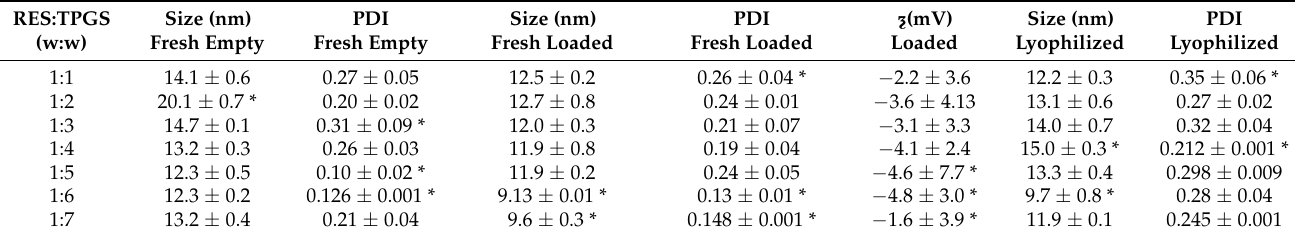
Table 2. Mean diameter (size, nm) and PDI of freshly prepared empty and loaded micelles and of formulations reconstituted from lyophilized powder, RES-TPGS formulations. The zeta potential ( B ) values were detected on fresh RES-TPGS micelles in water. Each value represents the mean ± SD (degrees of freedom =